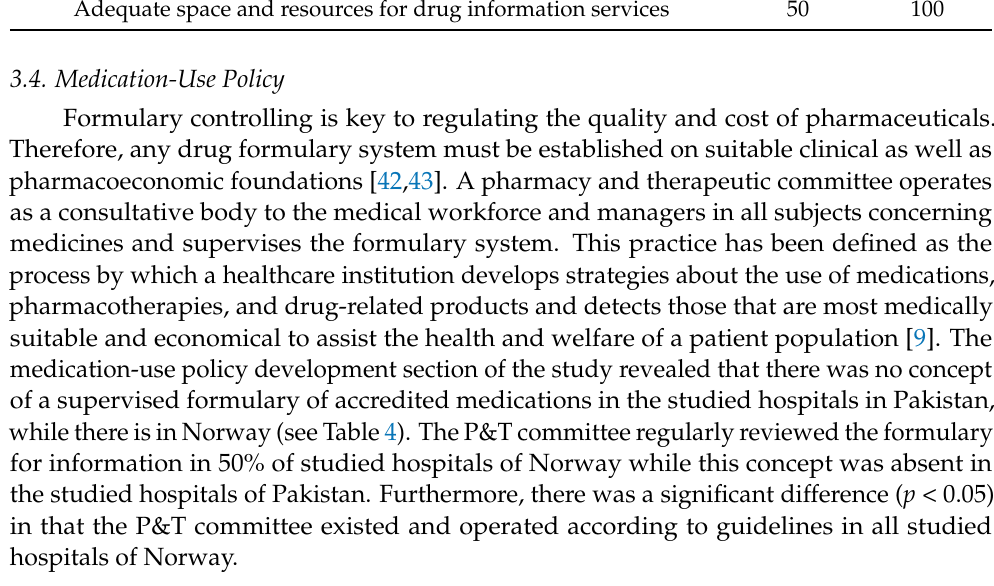
Table 4. Pharmacists’ assessments on medication-use policy